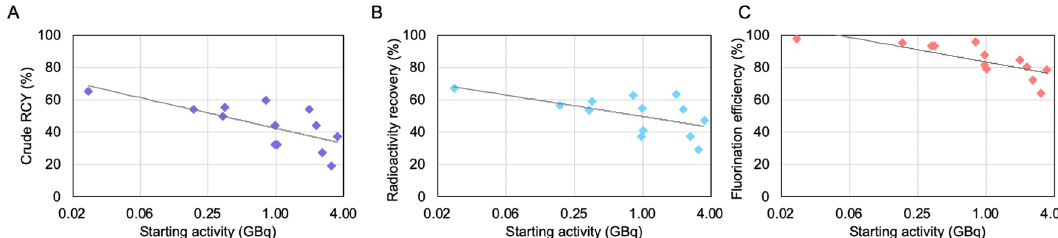
Figure 5. Performance of crude [ 18 F]FET droplet-based radiosynthesis as a function of starting activity.